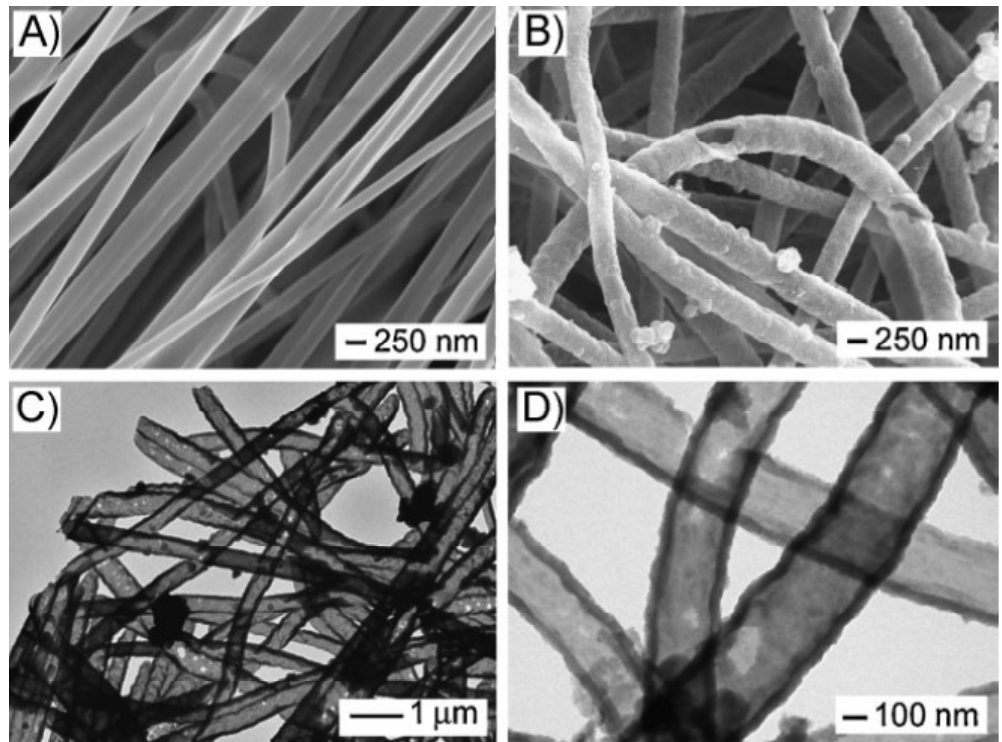
Figure 7. ( A ) SEM image of PCL nanofibers; ( B ) SEM image of PCL hollow nanotubes; ( C ) and ( D ) TEM images of PCL hollow nanotubes. Reprinted from [286] with permission from John Wiley and